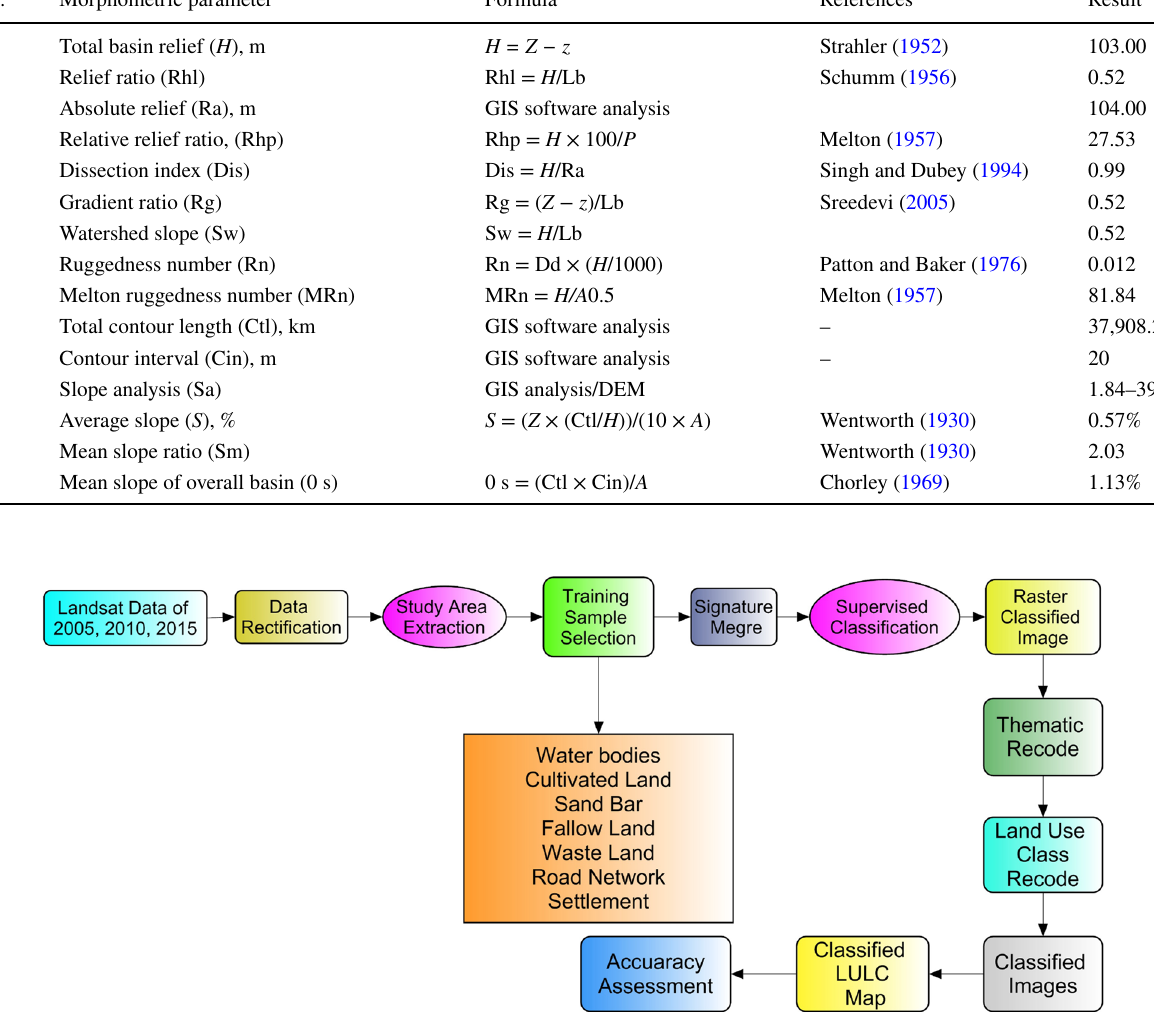
Fig. 4 Methodology of LULC process of Kosi